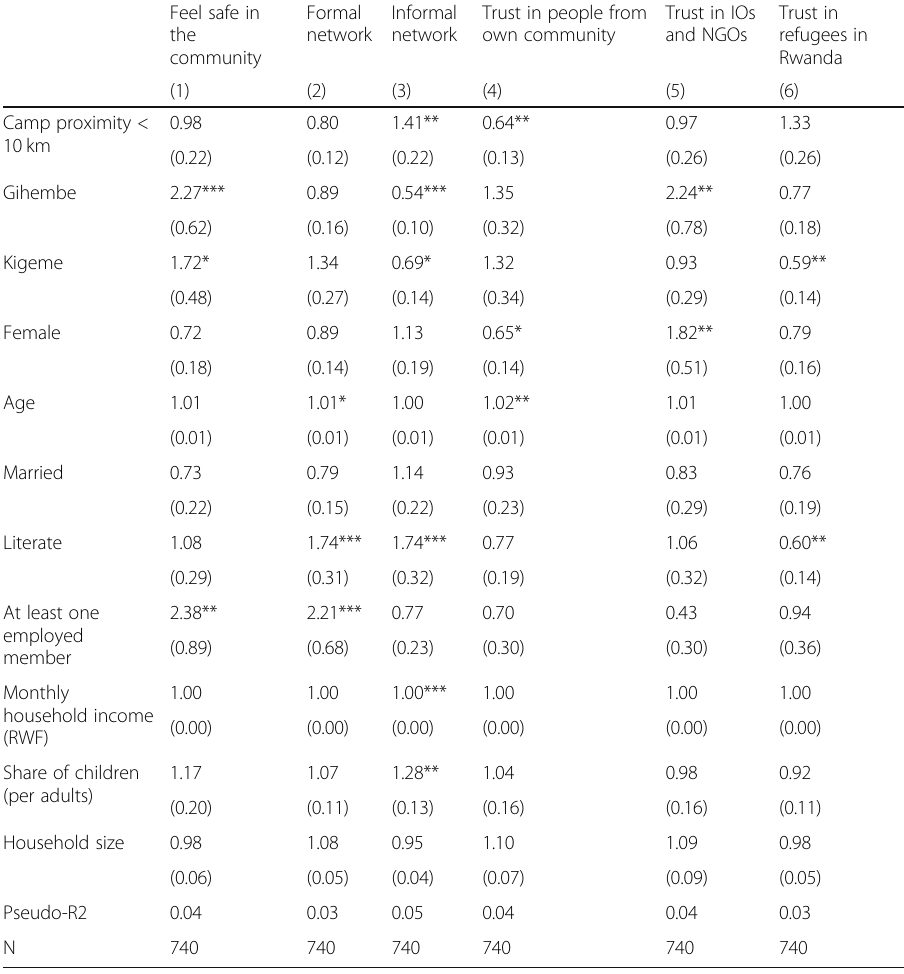
Table 5 Logistic regression analysis, by distance from a refugee camp (odds ratios)